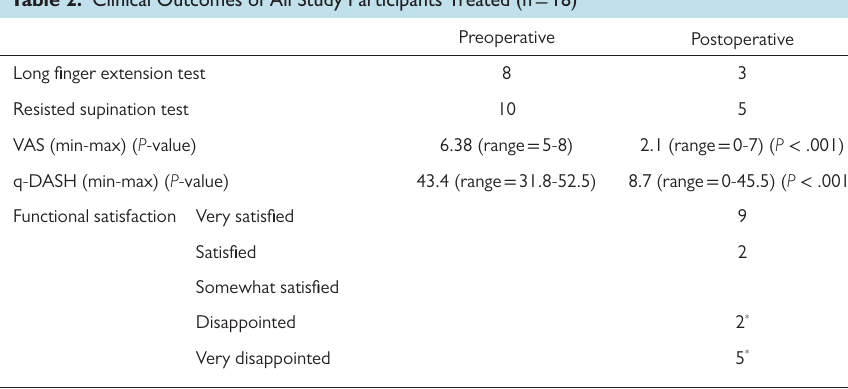
(Table 2). In the patient group who under-